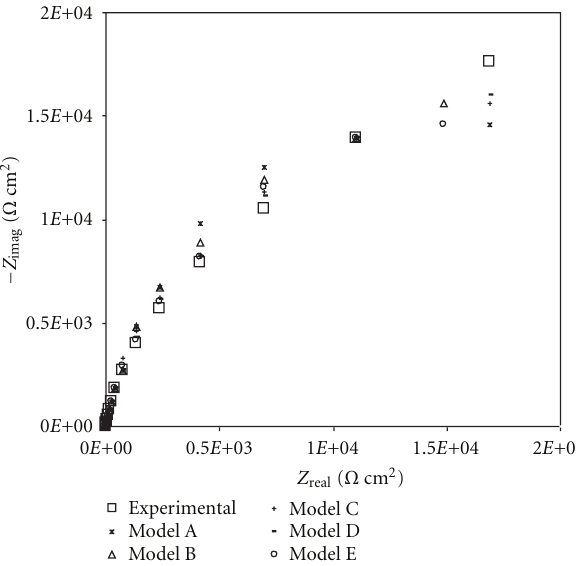
Figure 6: The fitting results of typical Nyquist plots for passive films on AISI 321 electrodes were formed potentiostatically at 0.4 V using the five